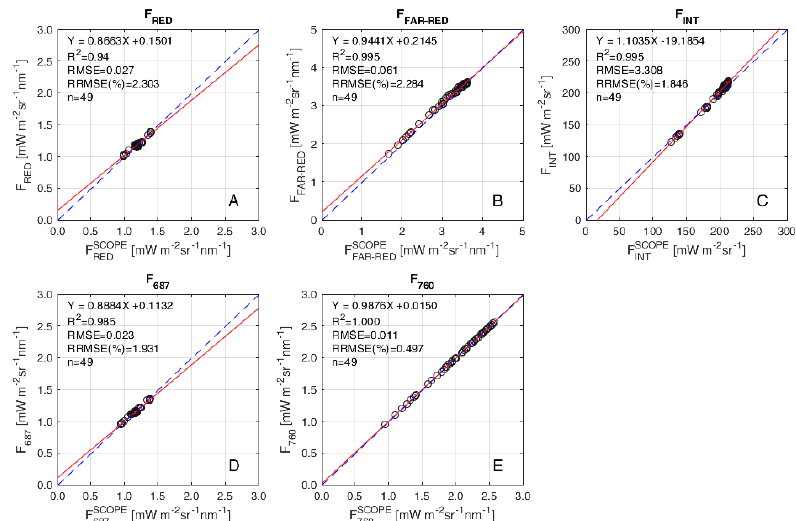
Figure 9. Scatterplots between reference and retrieved values at selected wavelengths: ( A ) maximum of the red peak; ( B ) maximum of far-red peak; ( C ) spectrally integrated F ; ( D ) F at 687 nm (O 2 -B band); ( E ) F at 760 nm (O 2 -A band). The red line is the linear least square fit whereas the dashed blue line represents the 1:1. Data refers to SNR = 1000.